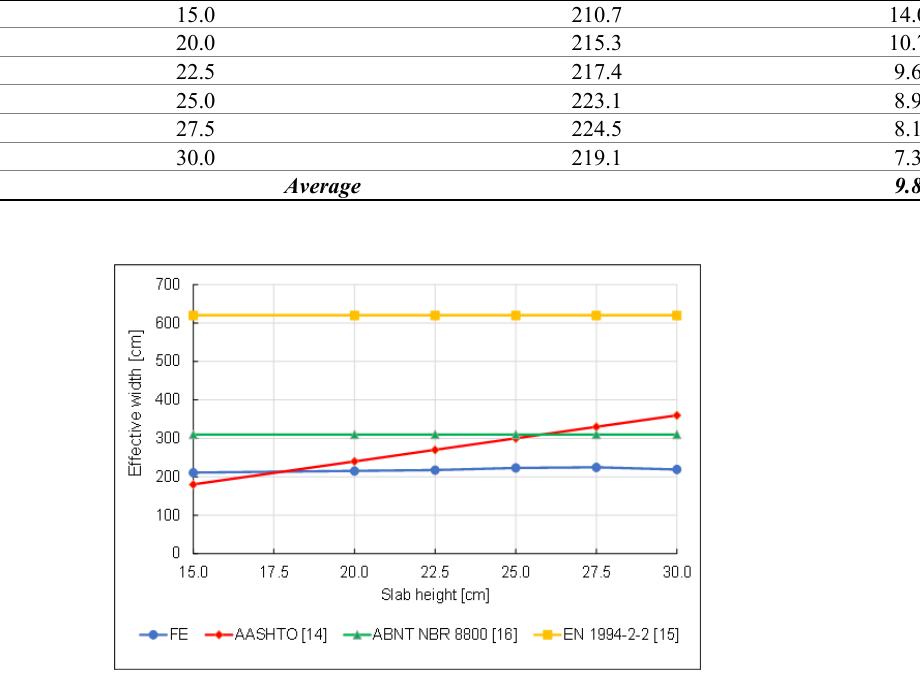
Figure 16. Effective width versus slab height for double box